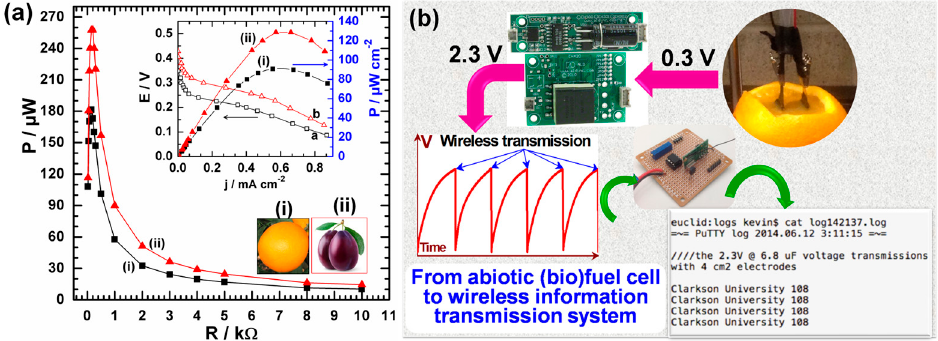
Figure 14. ( a ) Polarization characteristics of the fuel cell composed of the Pt/C-modified carbon paper cathode and the Au 80 Pt 20 /C-modified buckypaper anode implanted in an orange (i) and red plum (ii): The main panel shows the power released on the external variable resistance, the inset shows the cell voltage and the released power as the functions of the current density; ( b ) The orange with implanted electrodes (close view), the energy-harvesting circuit, the charging-discharging process and the message transmitted wirelessly using the power harvested by the FC from the orange. Reprinted and adapted with permission from Reference [192]. Copyright Wiley-VCH Verlag GmbH & Co. KGaA, 2015.